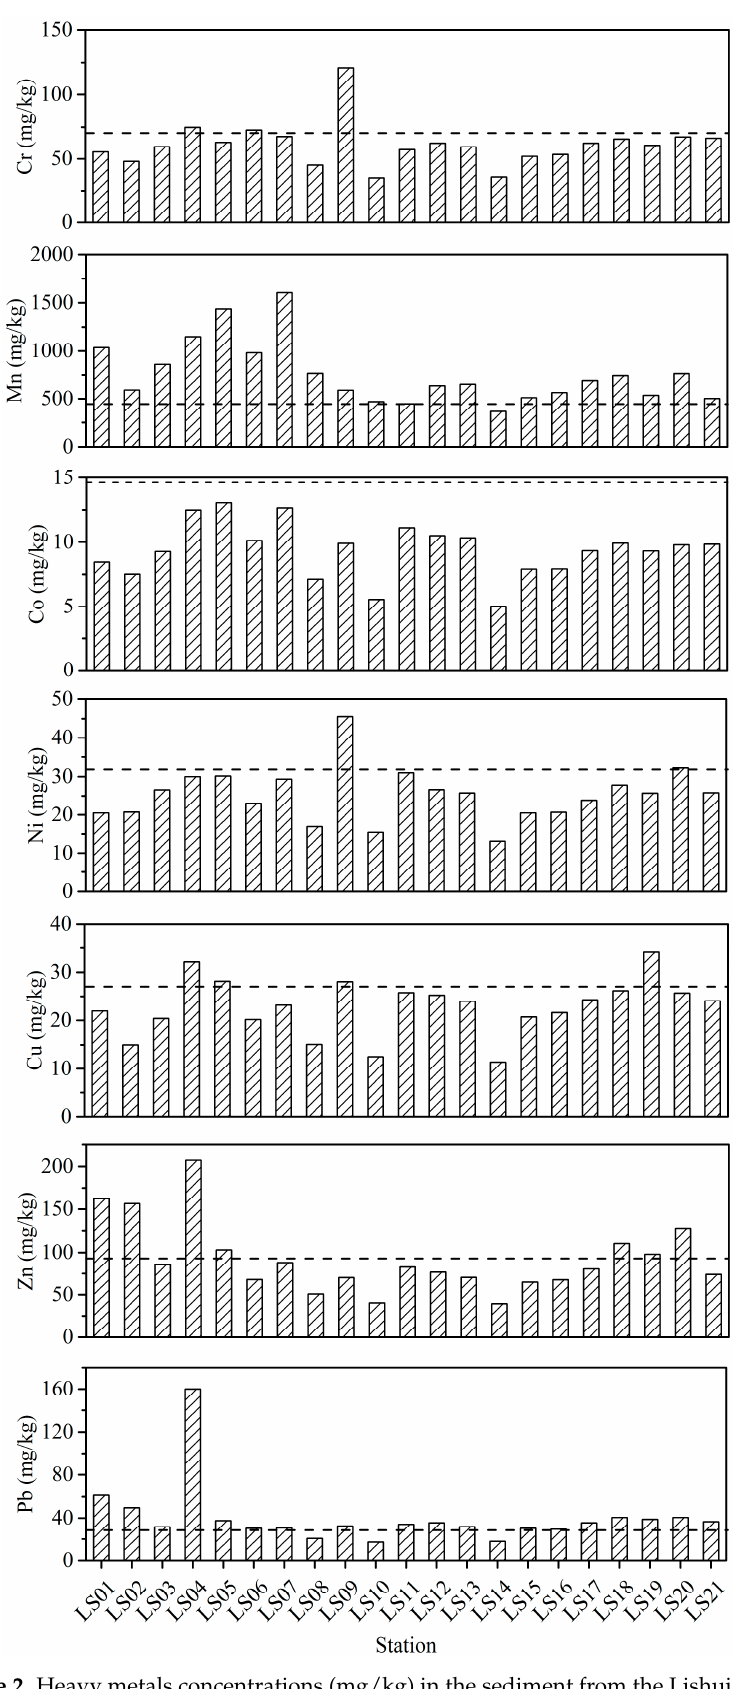
Figure 2. Heavy metals concentrations (mg/kg) in the sediment from the Lishui River.